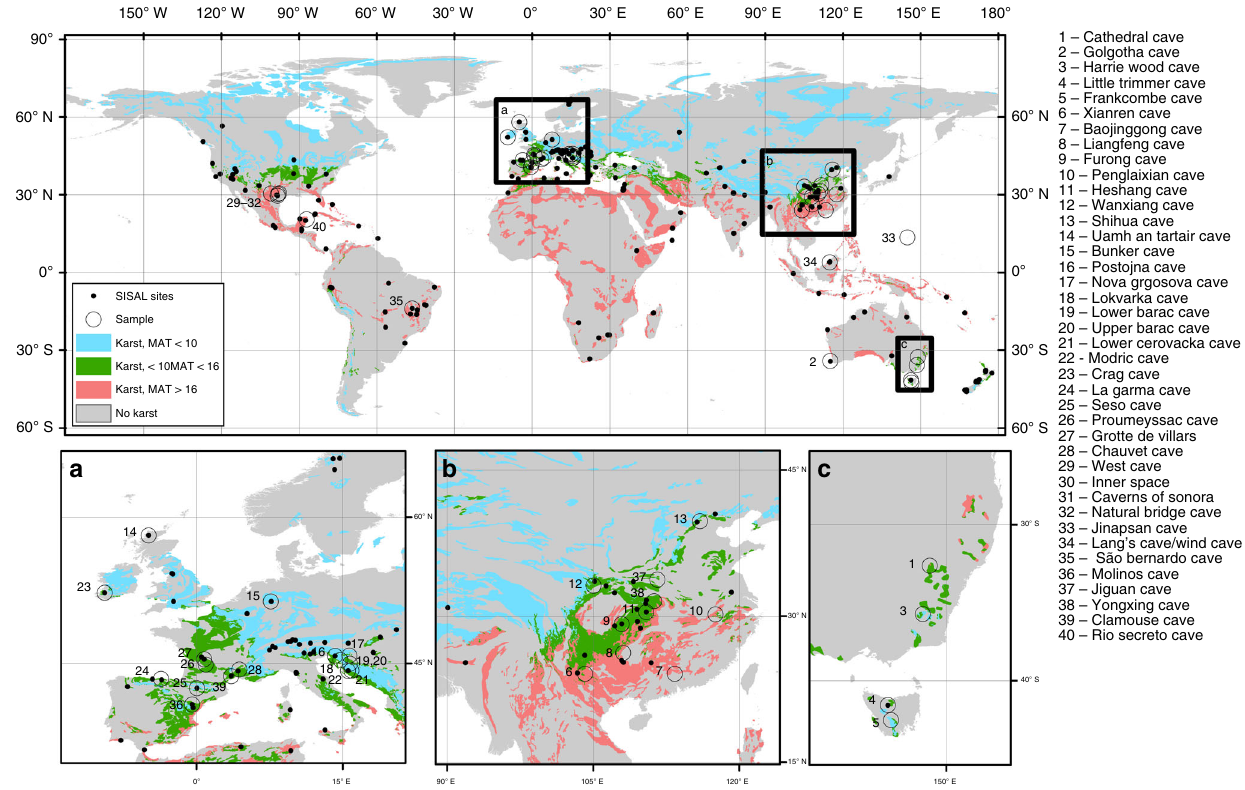
Fig. 1 Global map of sample sites, karst regions, surface temperature and speleothem records. Location of the cave δ 18 O dripwater samples (large circles). Global karst aquifer regions 41 are shown as coloured areas, with those with mean annual temperature < 10 °C (blue); 10 °C < mean annual temperature < 16 °C (green) and mean annual temperature > 16 °C (red). Dots show the locations with speleothem ( δ 18 O speleo ) records in the SISAL (Speleothem Isotopes Synthesis and AnaLysis Working Group) database 16,17 . a Europe, b Chinese monsoon region and c SE Australia. More information on the sites